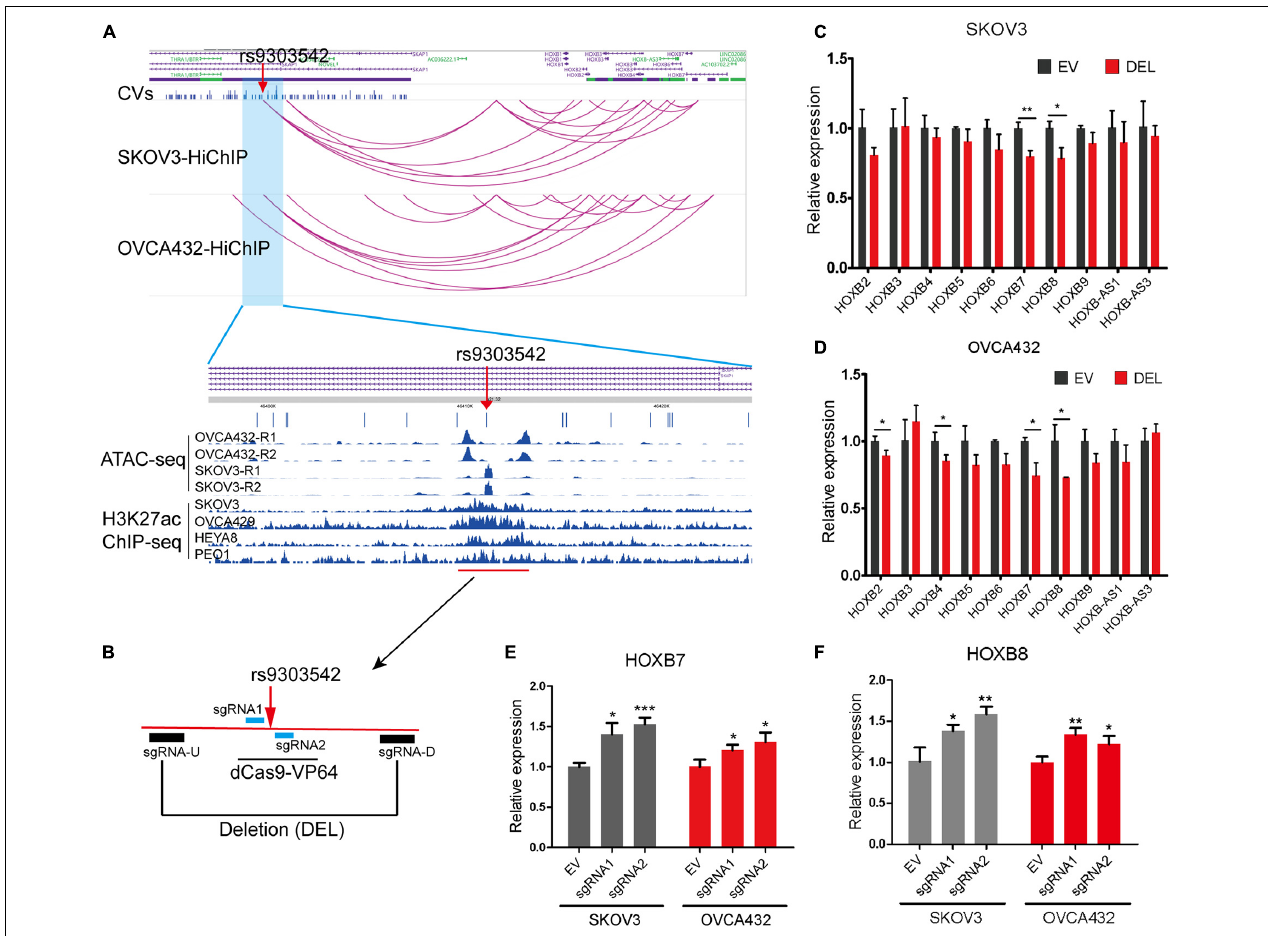
FIGURE 2 | Validation of regulatory relations between rs9303542 enhancer region and HOXB genes. (A) Interaction profiles of rs9303542 and HOXB genes at 17q21.32 and ATAC-seq and H3K27ac-ChIP signal enrichment at the rs9303542 region. (B) A schematic representation elucidating the design for CRISPR-Cas9 deletion and dCas9-VP64 activation experiments. sgRNA-U and sgRNA-D were cloned in px459v2 respectively and then cotransfected into the indicated cells to delete the 2000bp rs9303542 enhancer region. The sgRNA1/2 were separately cloned into MS2-gRNA-hU6 expression vector and then transfected into dCas9-VP64 stable expression SKOV3 and OVCA432 cells. (C,D) qPCR was used to detect the expression of HOXB genes between rs9303542 deleted (DEL) and vector control (EV) cells in SKOV3 (C) and OVCA432 (D) . The expression of HOXB1, HOXB-AS2, and HOXB-AS4 was too low to detect in both cell lines. (E,F) qPCR was used to compare the expression of HOXB7 (E) and HOXB8 (F) after sgRNA1/2 transfected (sgRNA1, sgRNA2) and empty vector transfected (EV) cells with dCas9-VP64 stable expression. Error bars, SD. ns: not significant, * p < 0.05, ** p < 0.01, *** p < 0.001 as determined by an unpaired, two-tailed Student’s t